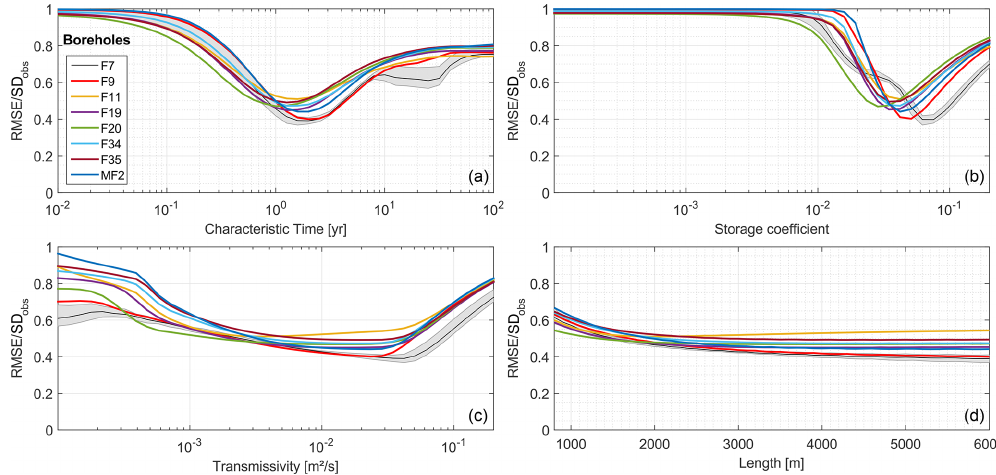
Figure 6. Evolution of the minimal normalized RMSE for Ploemeur wells as a function of model parameters: storage coefficient (b) , transmissivity (c) and aquifer length (d) . Evolution of characteristic time, a combination of the three parameters, is plotted in (a) . We selected the best prescribed potential recharge model for each point. The impact of the prescribed recharge is shown by the shaded area on borehole